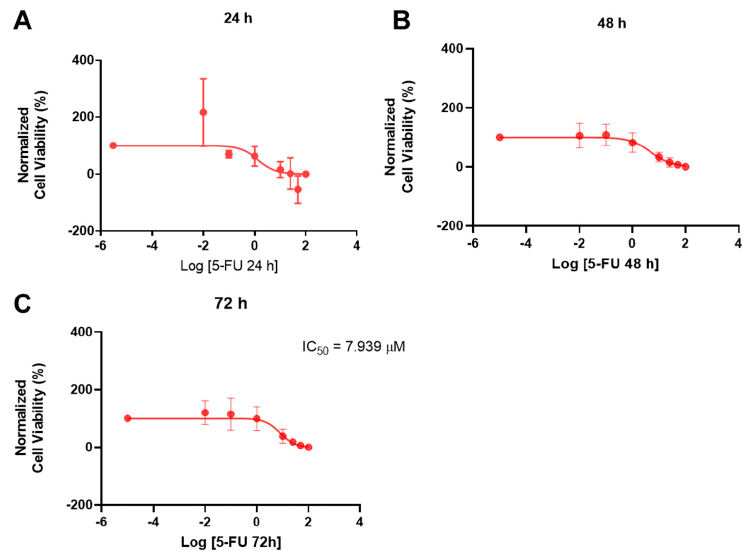
Figure 3. Dose-response curve and IC50 of PC-3 after exposure to increasing concentrations of 5-FU (0.01 − 100 µ M) for 24 h ( A ), 48 h ( B ), and 72 h ( C ). Control cells were treated with 0.01% DMSO (vehicle). Cell viability was obtained using the MTT assay and the results were normalized and are given as the mean ± SEM (24 h n = 3, 48 h. and 72 h n = 6).